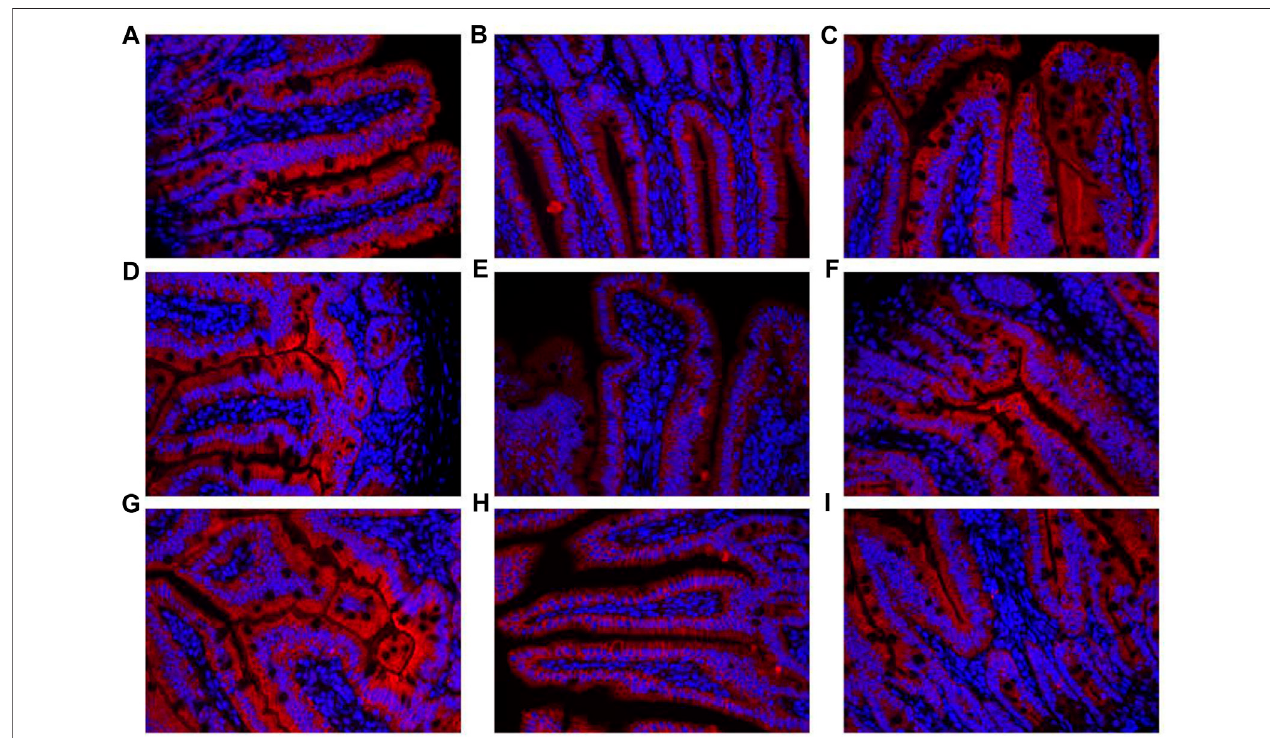
FIGURE 12 | Immuno fl uorescence of tight junction protein expressions in ileum of mice. (A) – (C) Expressions of Claudin-1 in the ileum of NS (A) , RS (B) and RS-P (C) groups. (D) – (F) Expressions of Occludin in the ileum of NS (D) , RS (E) and RS-P (F) groups. (G) – (I) Expressions of ZO-1 in the ileum of NS (G) , RS (H) and RS-P (I) groups. The tight junction proteins of. ZO-1-, claudin-1- and occludin are stained red, and the magni fi cation of all the fi gures are 40 × .